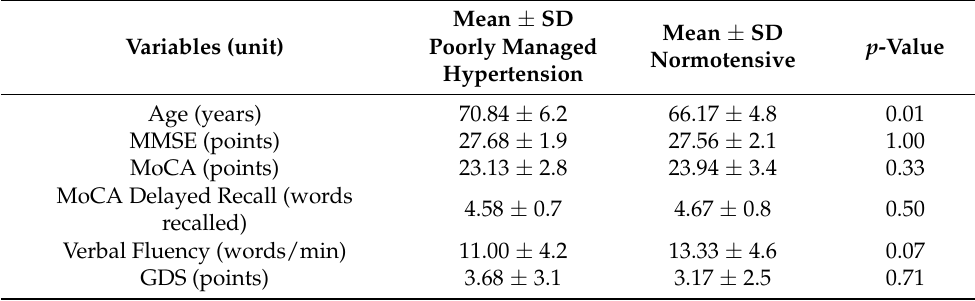
Table A1. Quantitative variables in patients with poorly managed hypertension (history of hyperten- sion diagnosis and values of sBP or dBP over 140/90 mmHg) vs. normotensive group (lack of history of hypertension and sBP and dBP lower than 140/90